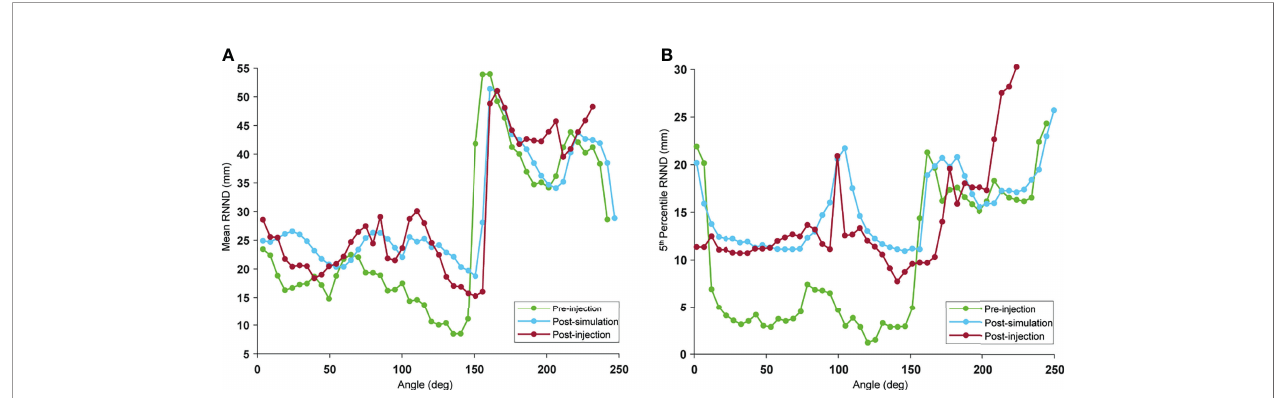
FIGURE 3 | Example of RNND pro fi le: the RNND pro fi le was calculated for every 5° angle bin, with 0° indicating the duodenum part adjacent to stomach (D1): pre- injection (green), post-simulation (blue), and post-injection (red). Every point on the curve shows (A) mean, and (B) 5th percentile of NND values of a single-angle